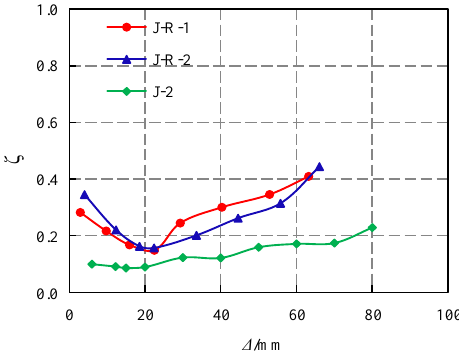
Figure 16. Equivalent viscous damping coefficient.